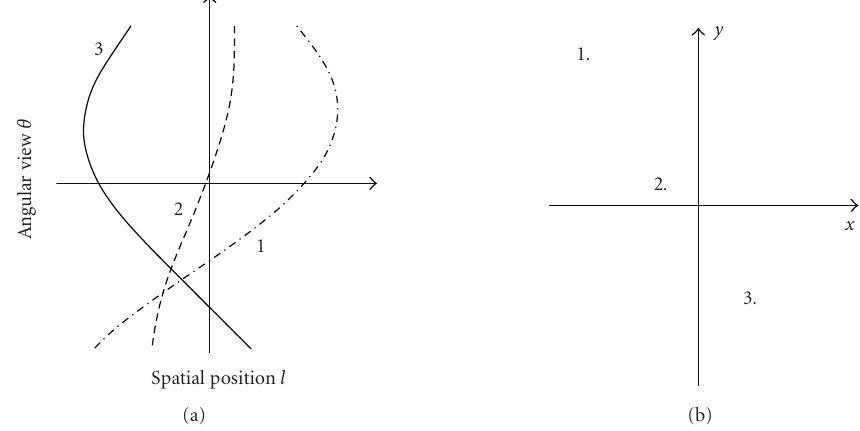
Figure 1: In (a), the sinogram is composed of sinusoidal signals. In SPECT, the sinusoids complete one cycle, that is, a full 360-degree view with di ff erent amplitudes and phases (the shown view corresponds to 180 ◦ ). The signals along the sinusoids contribute to the points or pixels in the reconstructed image, as shown in (b). The amplitude and phase of the sinusoidal signals (a) vary depending on the distance and spatial location of the points in the image (b).